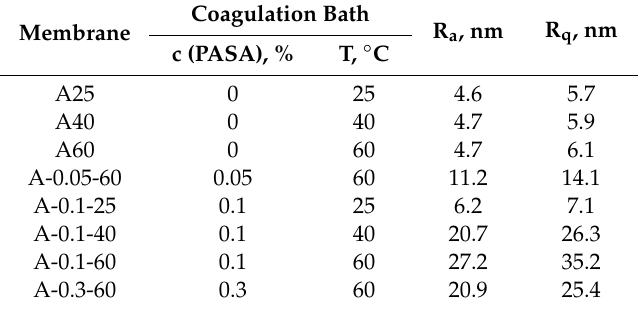
Table 2. Parameters of surface roughness determined by atomic force microscopy (AFM). Membrane